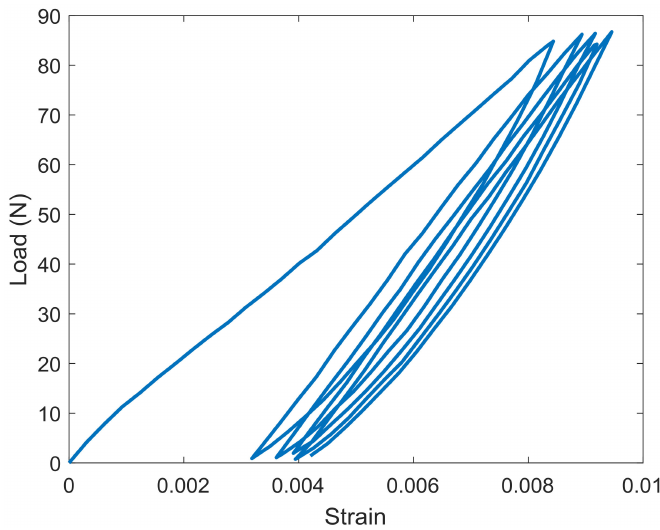
Figure 4. Five cyclic loading of a strand at 20% MBL.